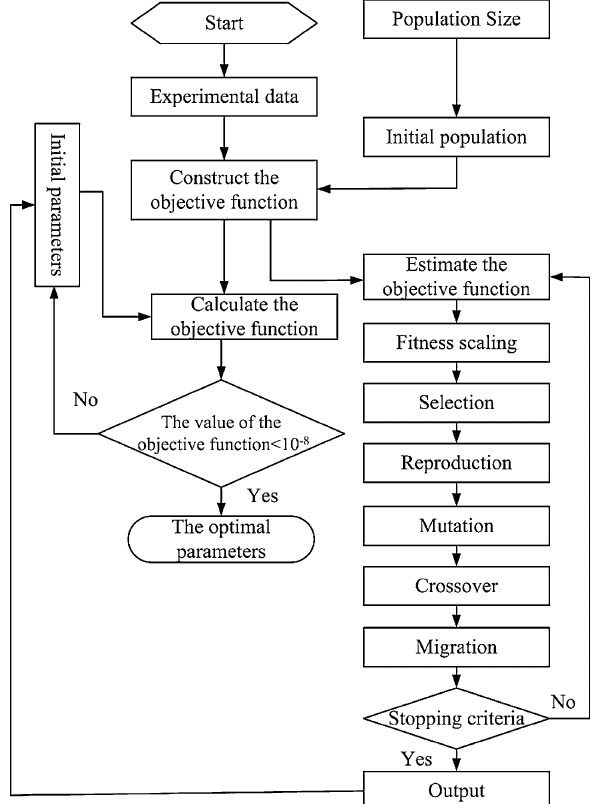
Fig. 1 Flow chart of the